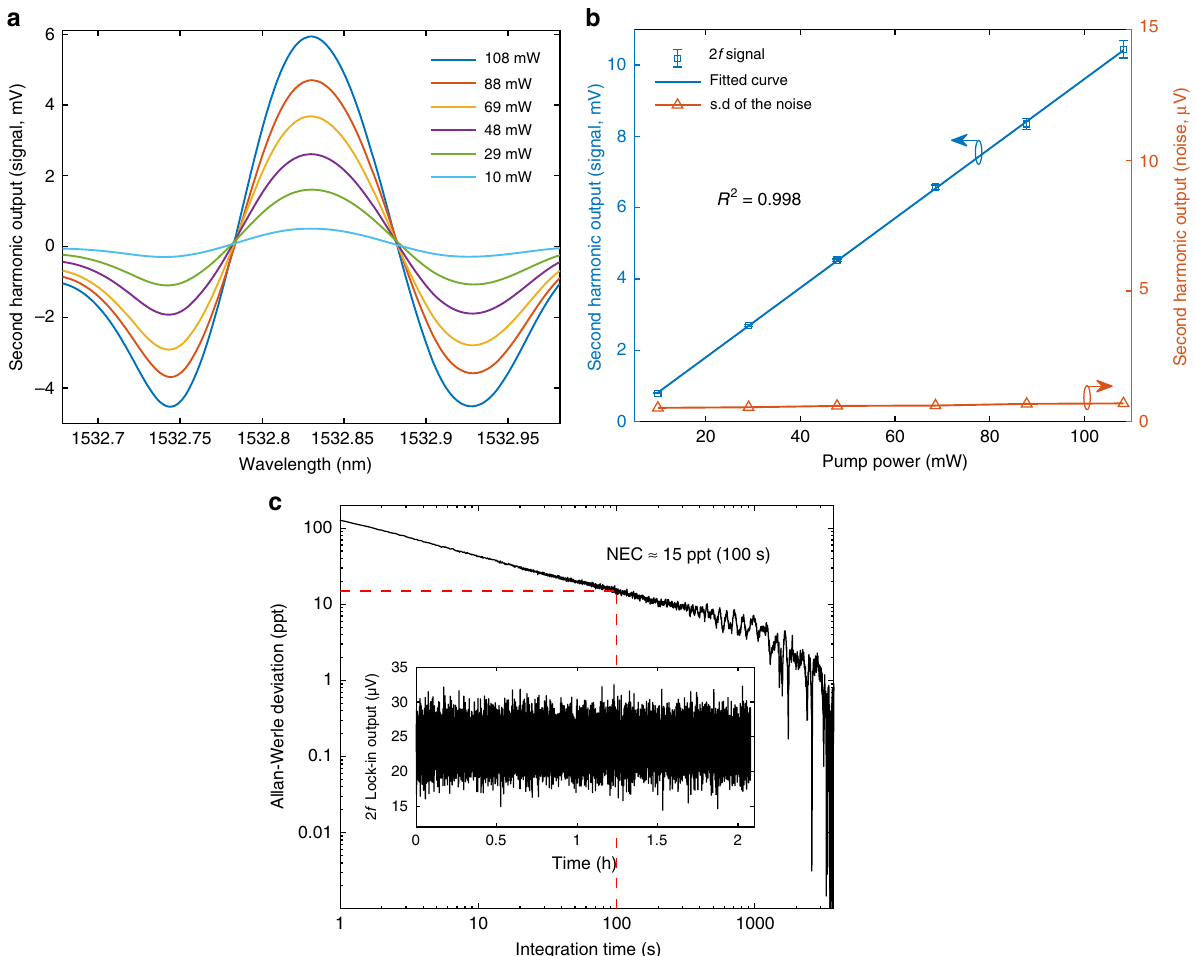
Fig. 4 Results of gas detection with the 4.67-m-long HCF gas cell. a The PT signal ( 2 f signal) with pump wavelength tuned across the P(13) line of C 2 H 2 . b The peak-to-peak ( p – p ) value of the 2 f signal and the s.d. of the noise as functions of pump power level. Error bars show the s.d. from 10 measurements and the magnitudes of the error bars are scaled up by fi vefold for clarity reason. Source data are provided as a Source Data fi le. The mean probe power on the PD is − 9 dBm. The lock-in time constant is 1 s and fi lter slope is 18 dB Oct − 1 , corresponding to 0.094 Hz detection bandwidth. c Allan – Werle plot based on the noise data over a period of 2 hours, which is shown in the inset. For the noise measurement, the lock-in time constant is 100 ms, corresponding to 0.94 Hz detection